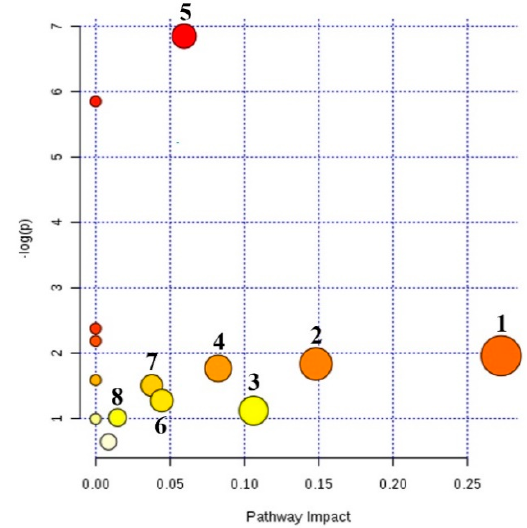
Figure 4. Summary of metabolic pathway analysis of potential metabolites. 1. Pentose and glucuronate interconversions; 2. Glyoxylate and dicarboxylate metabolism; 3. Arachidonic acid metabolism; 4. Steroid hormone biosynthesis; 5. Primary bile acid biosynthesis; 6. Glycerophospholipid metabolism; 7. Starch and sucrose metabolism; 8. Tryptophan metabolism.